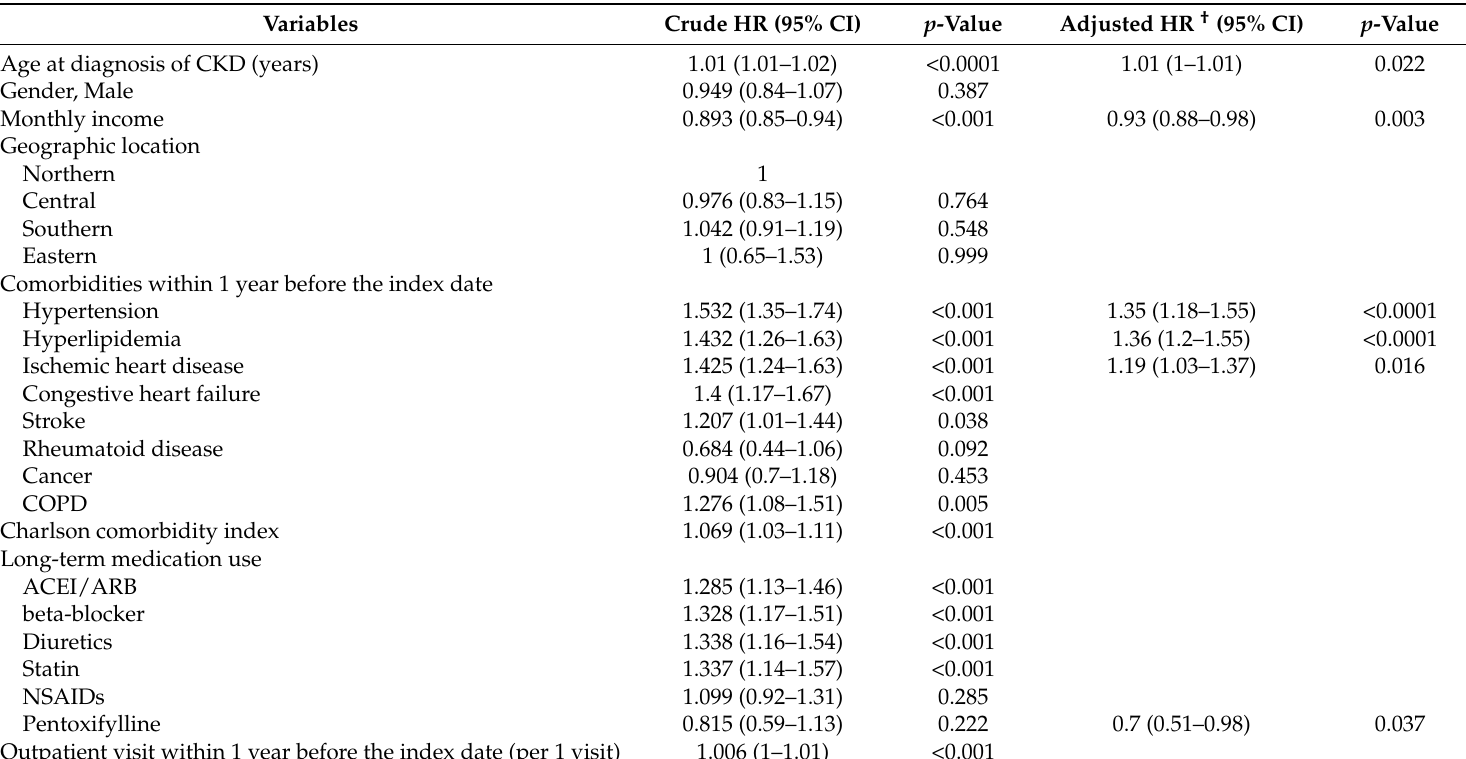
Table 3. The significant variables for new-onset DM after diagnosis of CKD in non–pre-existing DM patients ( n =